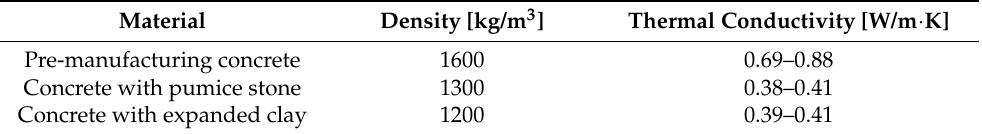
Table 10. Properties of concrete for different aggregates used